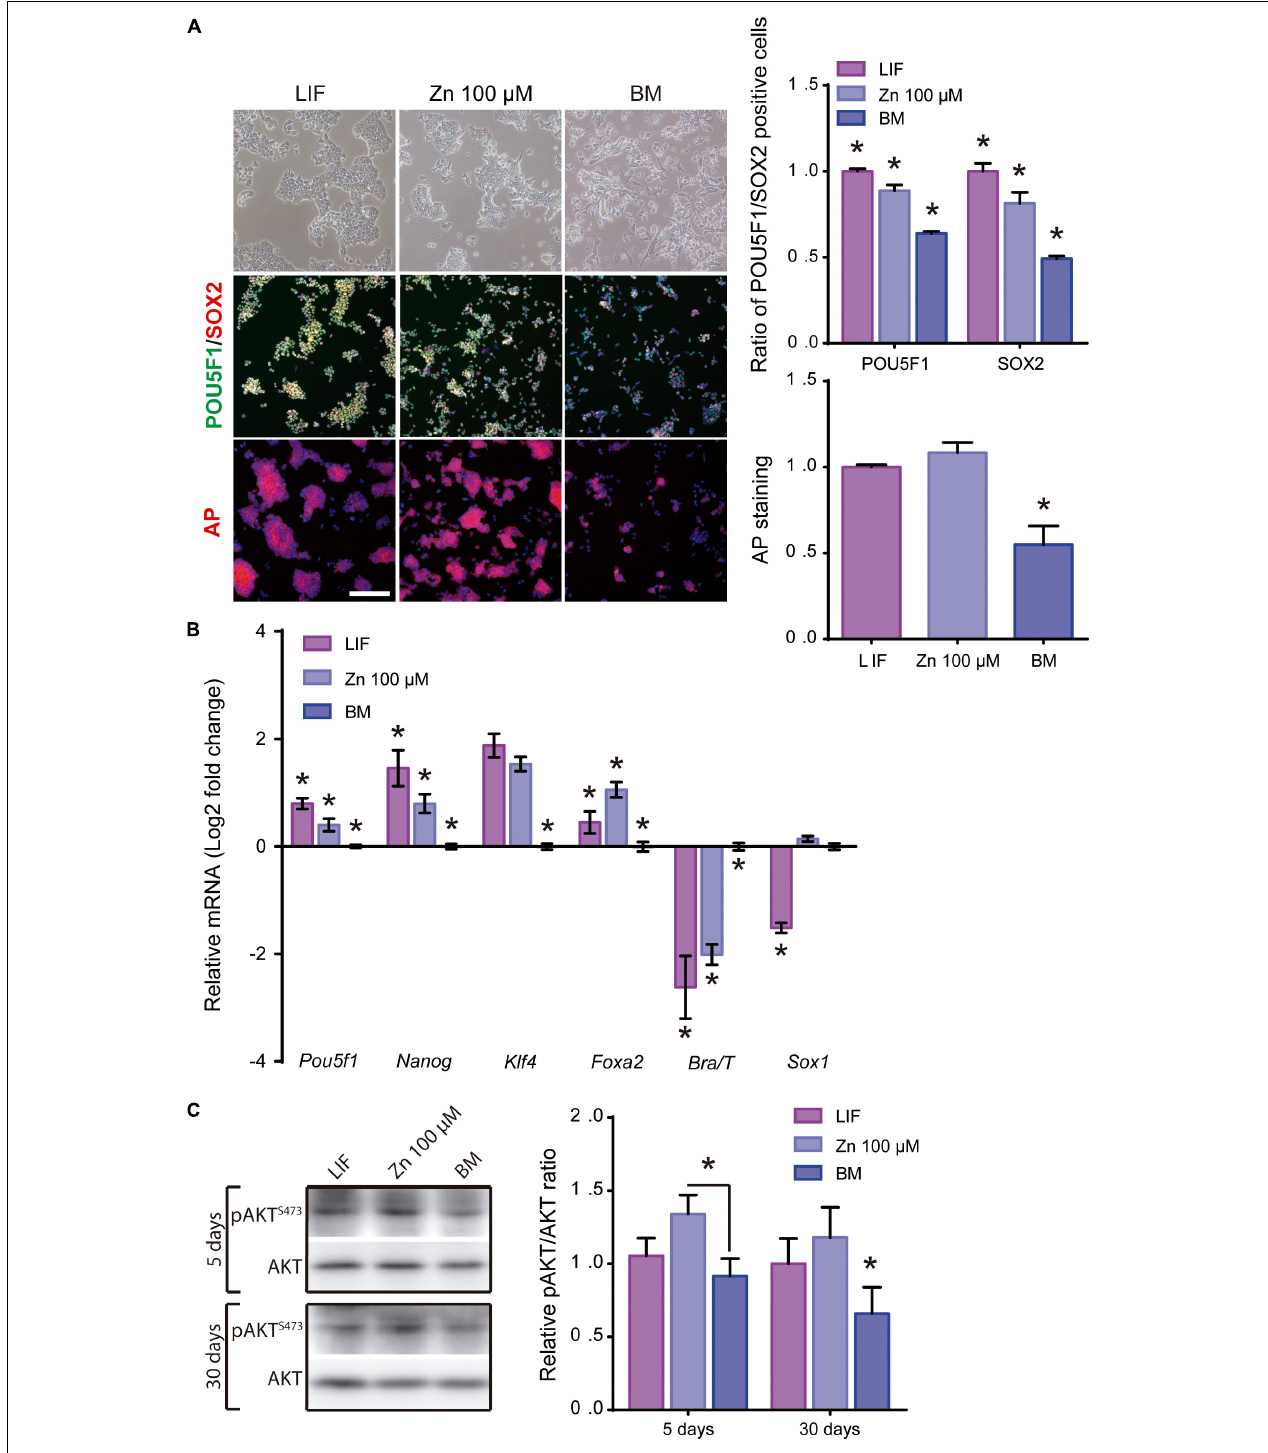
FIGURE 4 | Role of zinc in ESCs pluripotency maintenance after 30 days of culture. (A) Immunofluorescence detection of pluripotency markers: POU5F1-green, SOX2-red and alkaline phosphatase-red, determined after 30 days of ESCs culture, in BM and a medium supplemented with LIF or medium supplemented with 100 µ M of Zn 2 + ( n = 5). Scale bar: 200 µ m. (B) qPCR detection of pluripotency markers ( Pou5f1 , Nanog , Klf4 ) and differentiation markers (endoderm: Foxa2 ; mesoderm: Brachyury/T and ectoderm: Sox1 ). Gapdh was used as housekeeping gene ( n = 4). (C) Western blot detection of AKT and pAKT (S473) on ESCs cultured in BM and a medium supplemented with LIF or medium supplemented with 100 µ M of Zn 2 + after 1, 5, and 30 days of culture ( n = 4). Significant differences were determined by ANOVA test; ∗ p < 0.05.